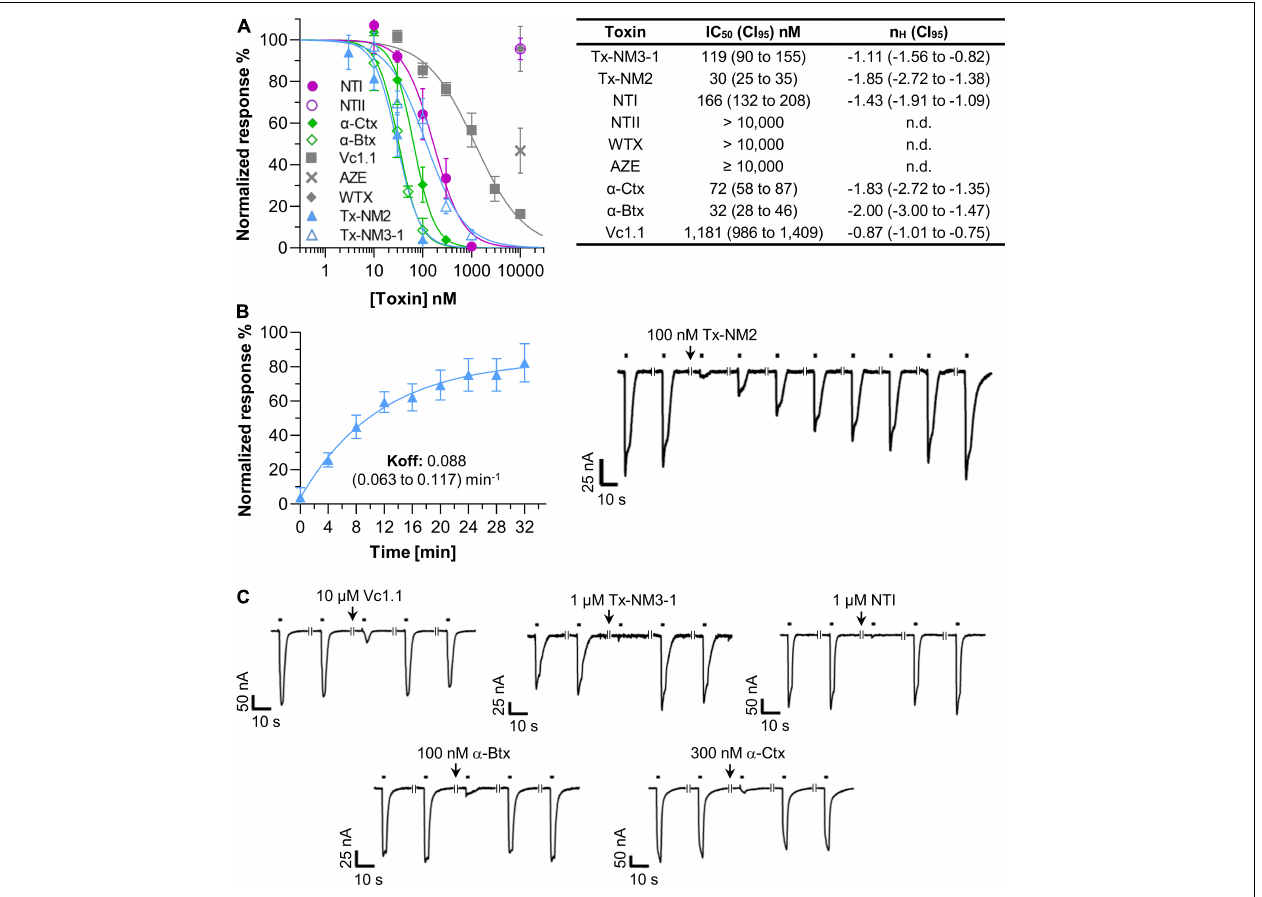
FIGURE 2 | Potencies of snake toxins at the Xenopus laevis oocyte-expressed human α 9 α 10 nicotinic acetylcholine receptor (nAChR). (A) Dose-Response curves and half-maximal inhibitory concentrations (IC 50 ) values of the indicated toxins. Responses to 2 s pulses of 40 µ M acetylcholine (ACh) were measured at a potential of –70 mV. Toxins were pre-incubated for 3 min in a static bath. nH: Hill-slope. 95% confidence intervals (CI 95 ) are given in parenthesis. Note that the high values of the Hill coefficients suggest that a 3 min pre-incubation with the toxins is insufficient for complete binding and IC 50 values might therefore be underestimated (compare Supplementary Figure 1 ). However, for practical reasons (decreasing stability of oocytes in the static bath, need of large toxin amounts in case of superfusion), all measurements were performed after 3 min pre-incubation. (B) Recovery of α 9 α 10 current responses after a block induced by 100 nM Tx-NM2 Representative current traces are shown. Black bars indicate application of 40 µ M ACh. Interruptions in the traces indicate a 4 min interval. (C) Representative current traces showing the fast dissociation of the indicated toxins from the α 9 α 10 nAChR. Recording conditions are as in (B) . Each point represents the mean of 3–5 measurements from different oocytes of least two different frogs. Error bars represent the standard deviation